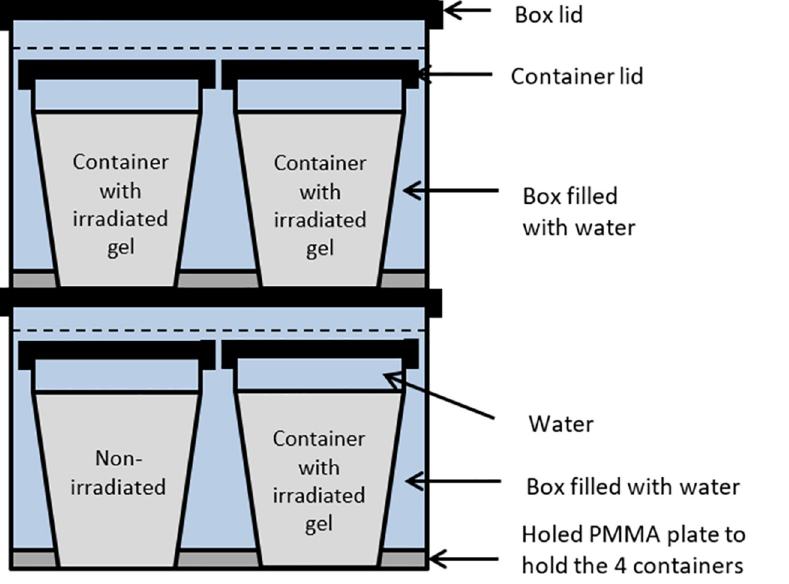
Fig 2. Sagittal view of the plastic containers acquisition set-up inside the MR